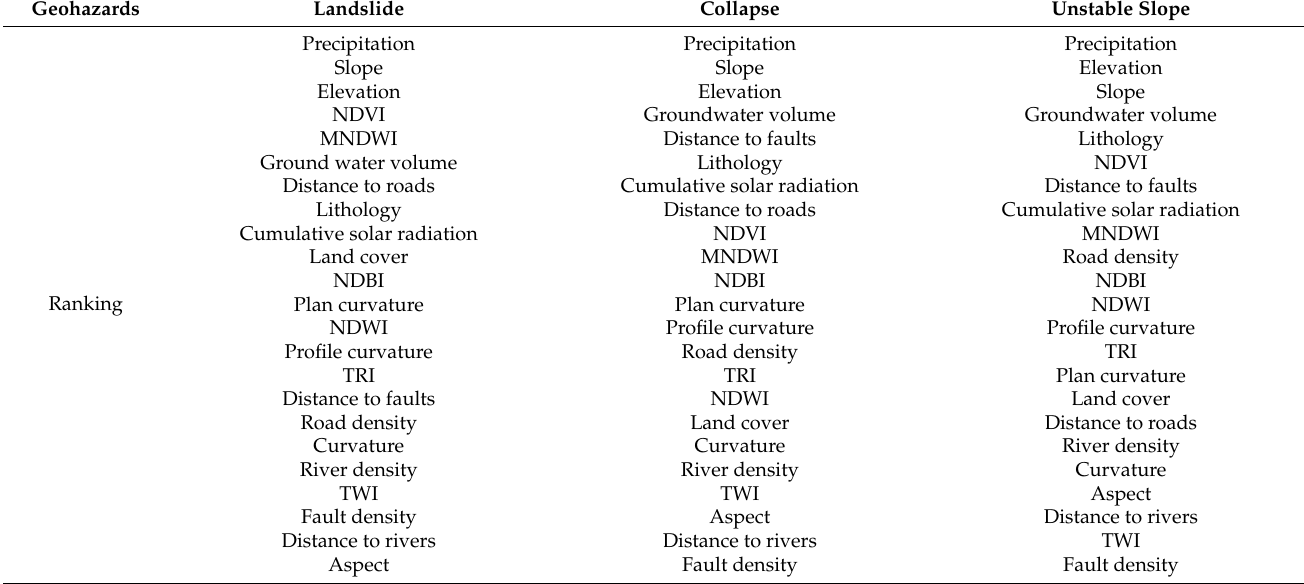
Table 8. Relative ranking results of feature importance using the wrapper-MDI feature selection method.